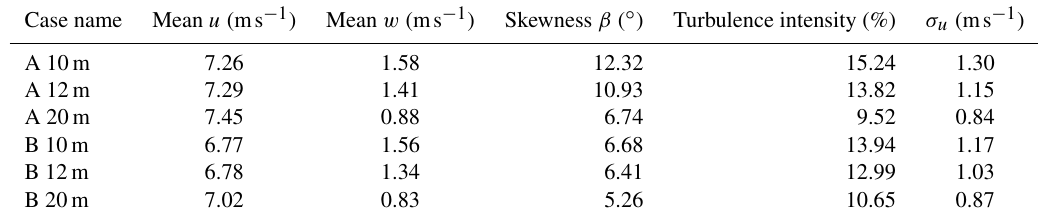
Table 3. Mean wind speeds and turbulence intensities at the rooftop.